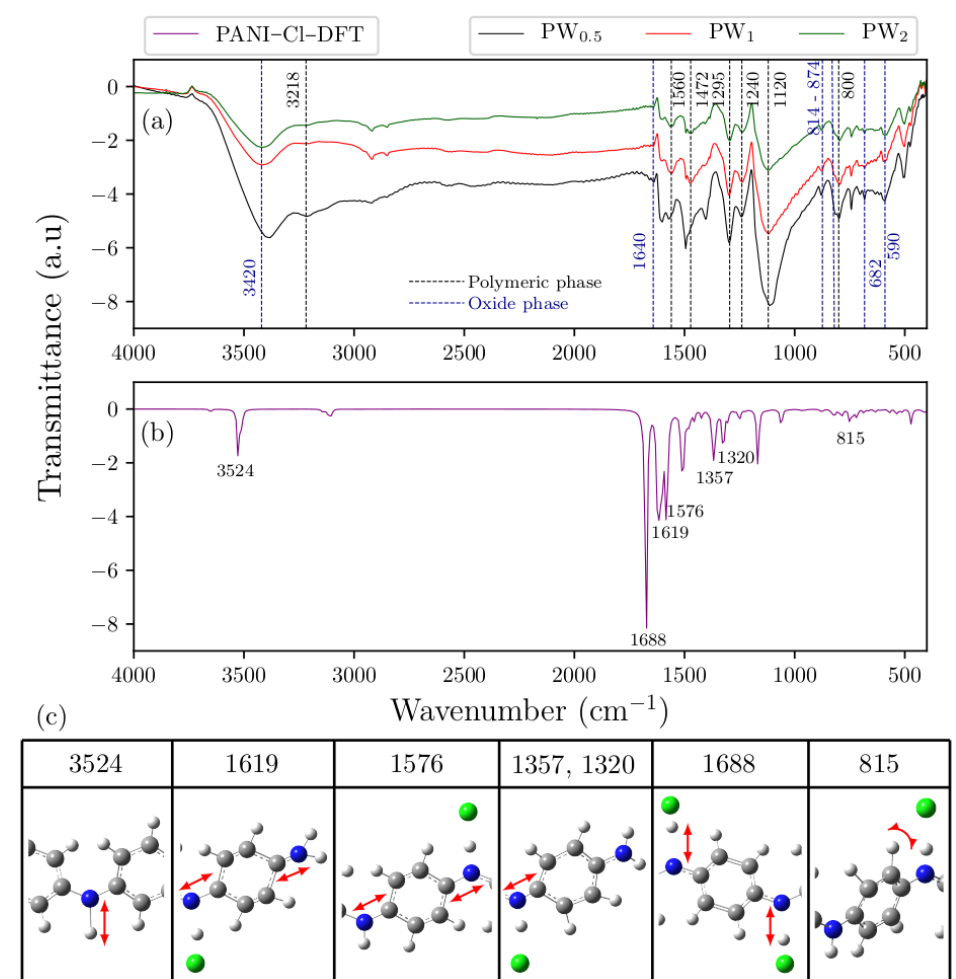
Figure 4. ( a ) Spectra of the as -synthesized PW 0.5 , PW 1 and PW 2 nanocomposites showing the bands corresponding to the main vibrational modes. The bands resulting from the stretching and deformations of the polymeric phase were clearly identified; ( b ) Theoretical spectrum of ES–PANI and ( c ) Observed vibrational modes.